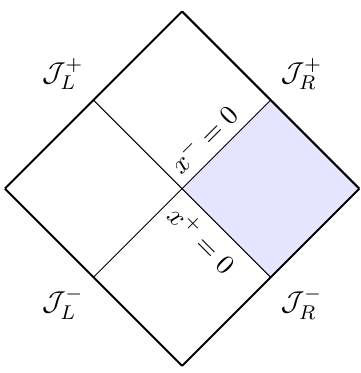
Figure 2 . Penrose diagram of flat space. The shaded region corresponds to the right Rindler